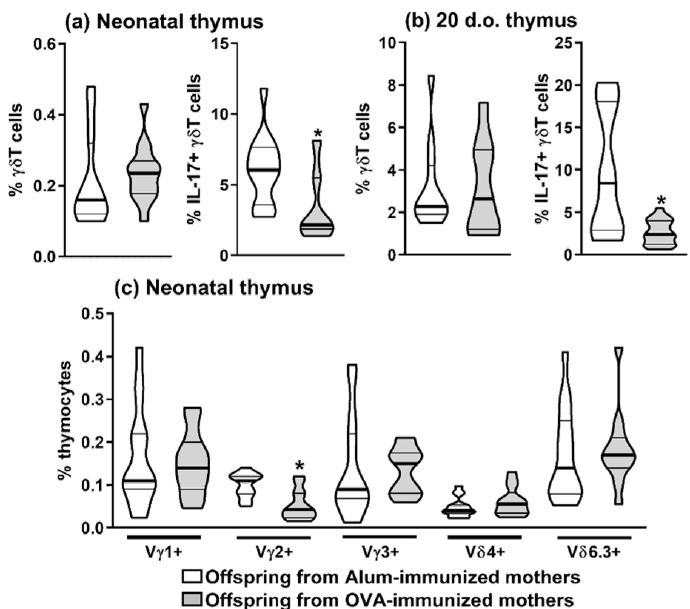
Figure 2. Inhibition of offspring thymic maturation of IL-17-producing and V γ 2 + γδ T cells mediated by maternal immunization with OVA. Offspring from OVA-immunized ( n = 9) or Alum-immunized ( n = 10) mothers were evaluated. Thymic frequency of total and IL-17-producing (IL-17 + ) γδ T cells were evaluated by flow cytometry at 3 ( a ) and 20 ( b ) d.o. offspring. Additionally, thymic frequency of V γ 1, V γ 2, V γ 3, V δ 4, and V δ 6.3 γδ T cells was evaluated at 3 ( c ) d.o. offspring by flow cytometry. The results are illustrated with violin plot (truncated) representing median (bold line) and the quartiles (thin lines). * p ≤ 0.05 compared to Alum-immunized offspring.